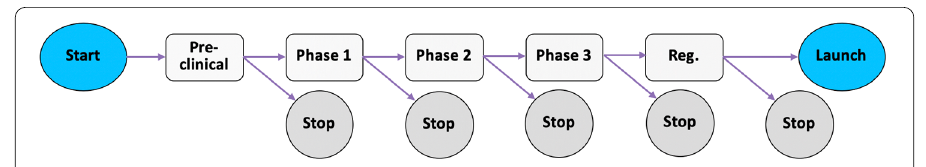
Figure 1 Schematic illustration of the phases of a drug development process